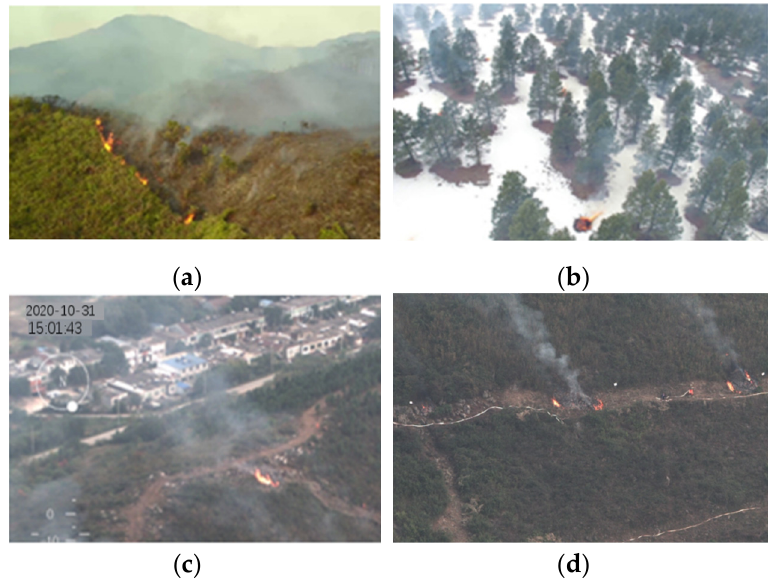
Figure 2. Pictures containing small-target fires: ( a ) small-target forest fires captured by forest video- monitoring equipment; ( b ) small-target forest fire photographed by UAV at low altitude; ( c , d ) small-target forest fires photographed by UAV at high altitude.